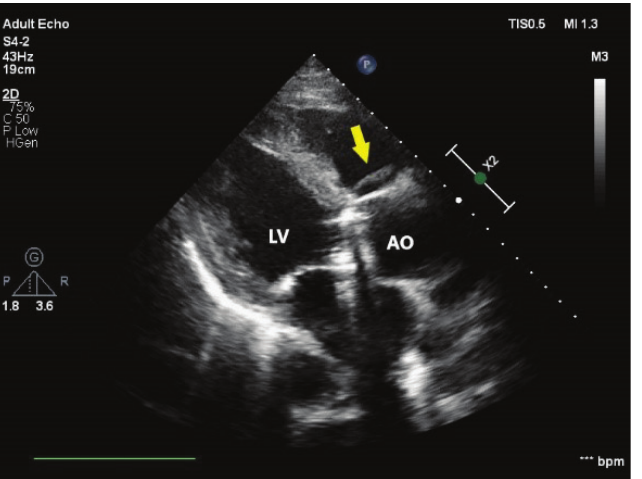
Figure 4 - Midesophageal long axis view with color flow doppler of fistula from aortic root to right ventricle outflow tract (RVOT)